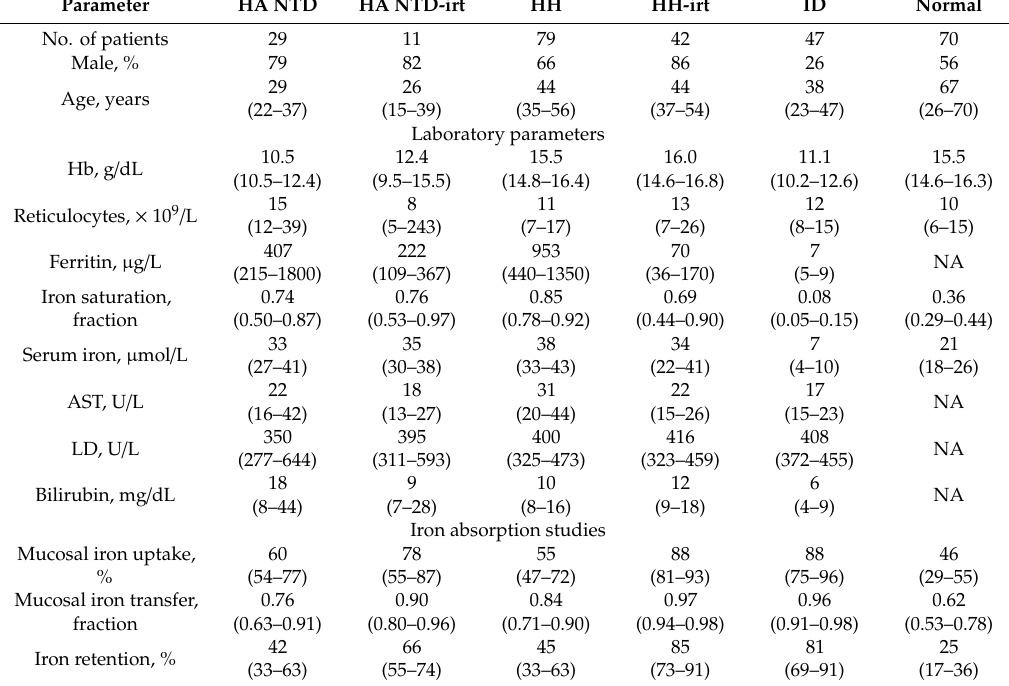
Table 1. Presented values are medians with interquartile ranges (IQR). Iron uptake, retention and transfer were calculated from the amount of 59 Fe and 51 Cr in the body 24 h after the oral iron test dose (uptake) and 14 days after the oral iron test dose (retention). Mucosal iron transfer is the fraction of iron retained after uptake. HA NTD hereditary anemia non-transfusion dependent; HH hereditary hemochromatosis; ID iron deficiency; irt iron reducing therapy (either phlebotomies or deferoxamine). AST aspartate aminotransferase; Hb hemoglobin; LD lactate